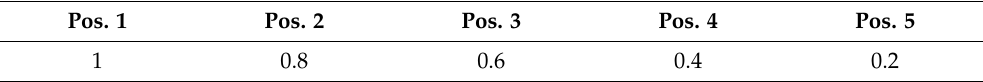
Table 5. Values assigned to the first five positions in the ranking.